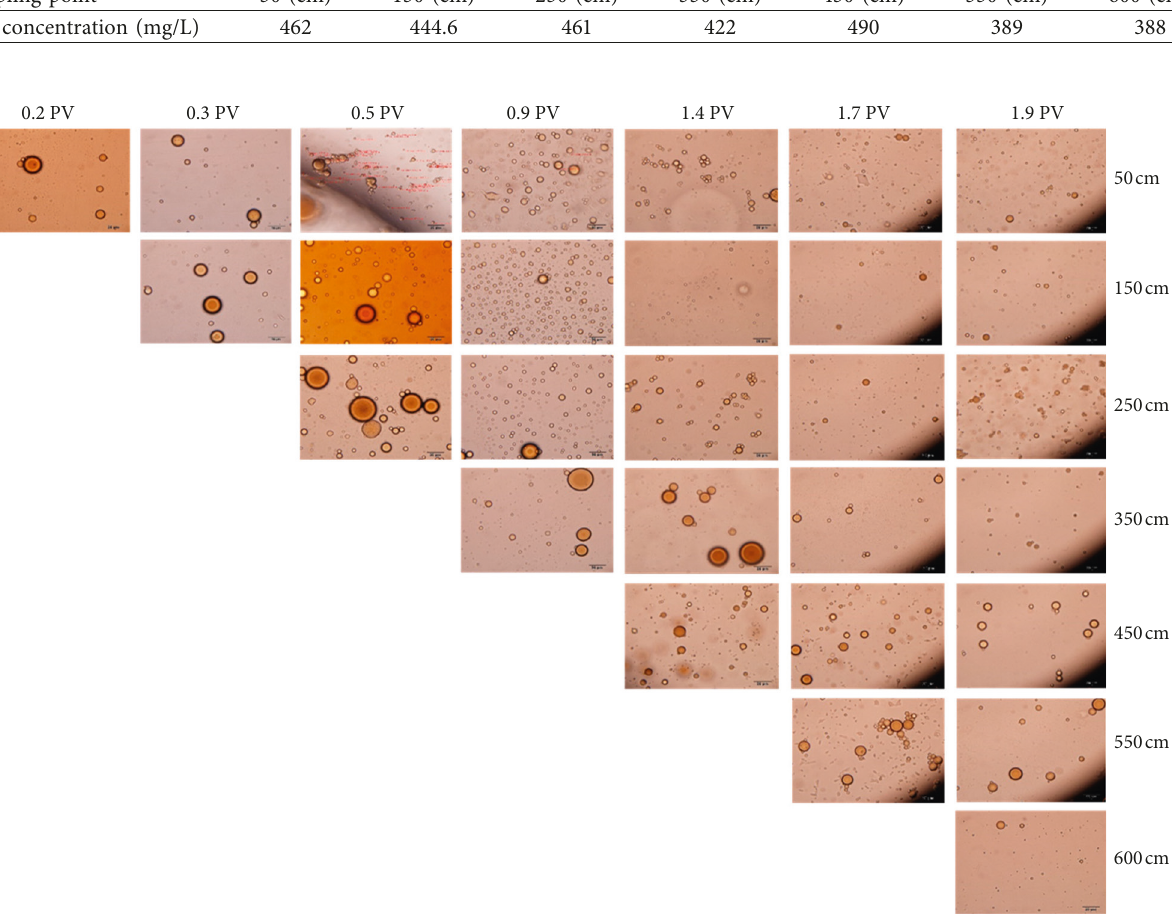
Figure 6: Microphotograph of emulsion (1,000 × ) at the sampling point. The pore volume is the injected volume of the injection inlet. The first picture of each sampling point means the occurrence of emulsification at the sampling point. Table 5: Emulsification changes at each